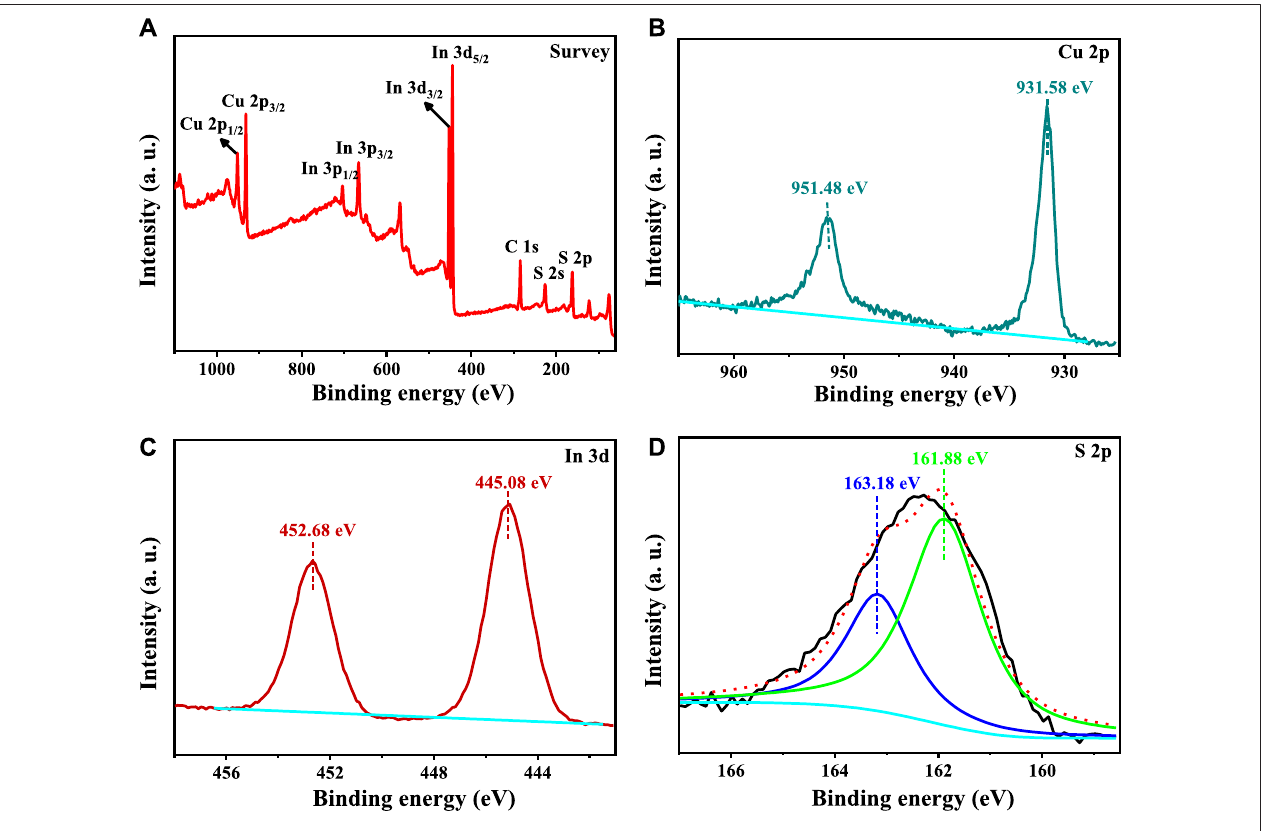
FIGURE 3 | (A) Survey, (B) Cu 2p, (C) In 3days, and (D) S 2p XPS spectra of our synthesized CuInS 2